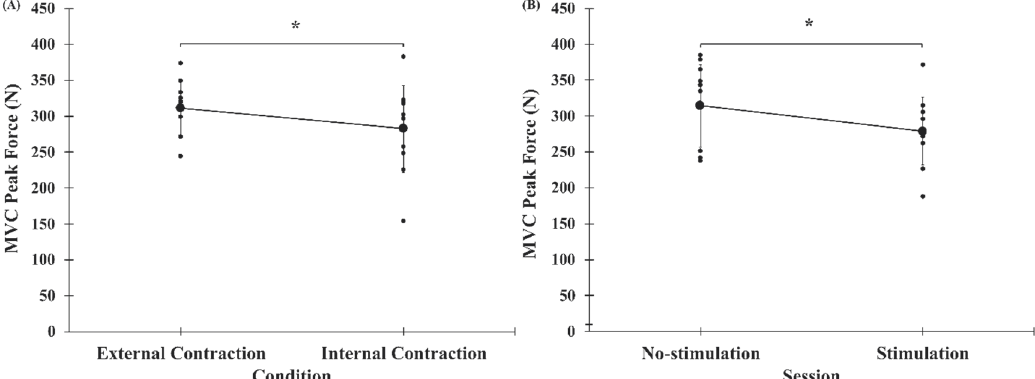
Figure 4. Peak force values for MVCs, measured in Newtons (N). Smaller points represent individual participant data, larger points represent mean, and error bars represent one standard deviation. ( A ) Peak force values for external versus internal conditions, collapsed across all trials (trial 1 to trial 6) and sessions (no-stimulation, stimulation), demonstrating the significant main e ff ect of CONDITION. ( B ) Peak force values for no-stimulation versus stimulation session, collapsed across all trials (trial 1 to trial 6) and conditions (external condition, internal condition), signifying the significant main e ff ect of SESSION. *, statistically significant at p <